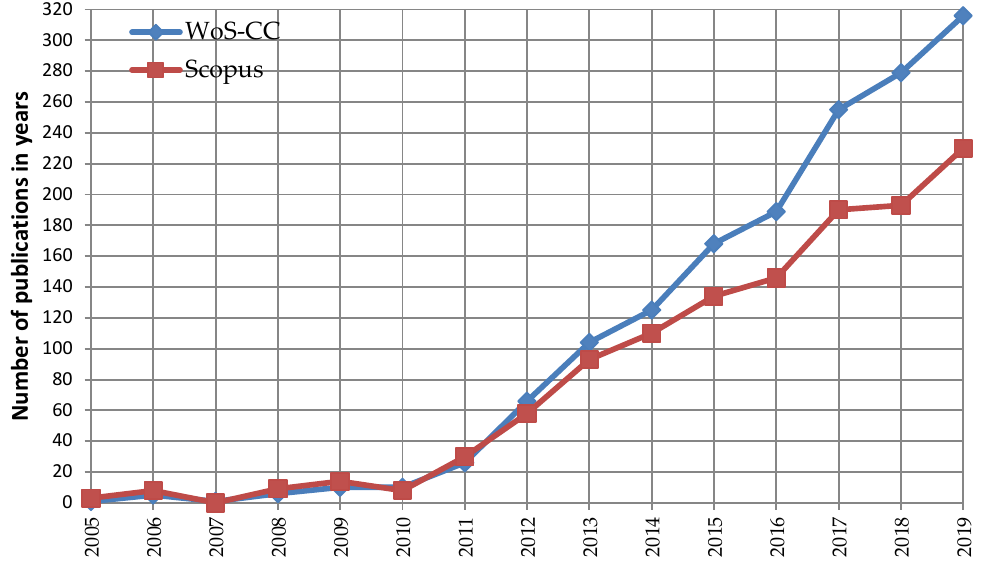
Figure 4. Number of articles in years indexed in WoS-CC and Scopus — 2005 – 2019.